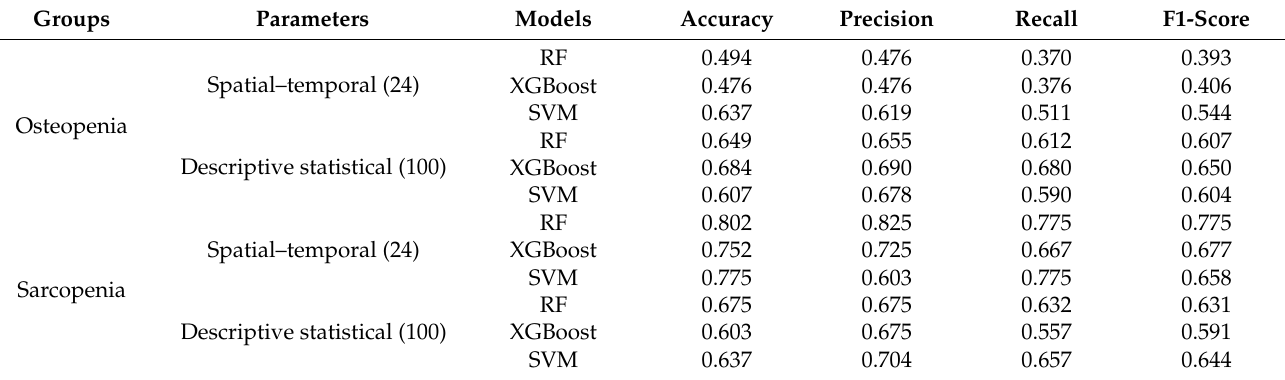
Table 5. Identification result of RF, XGBoost, and SVM (accuracy, precision, recall and